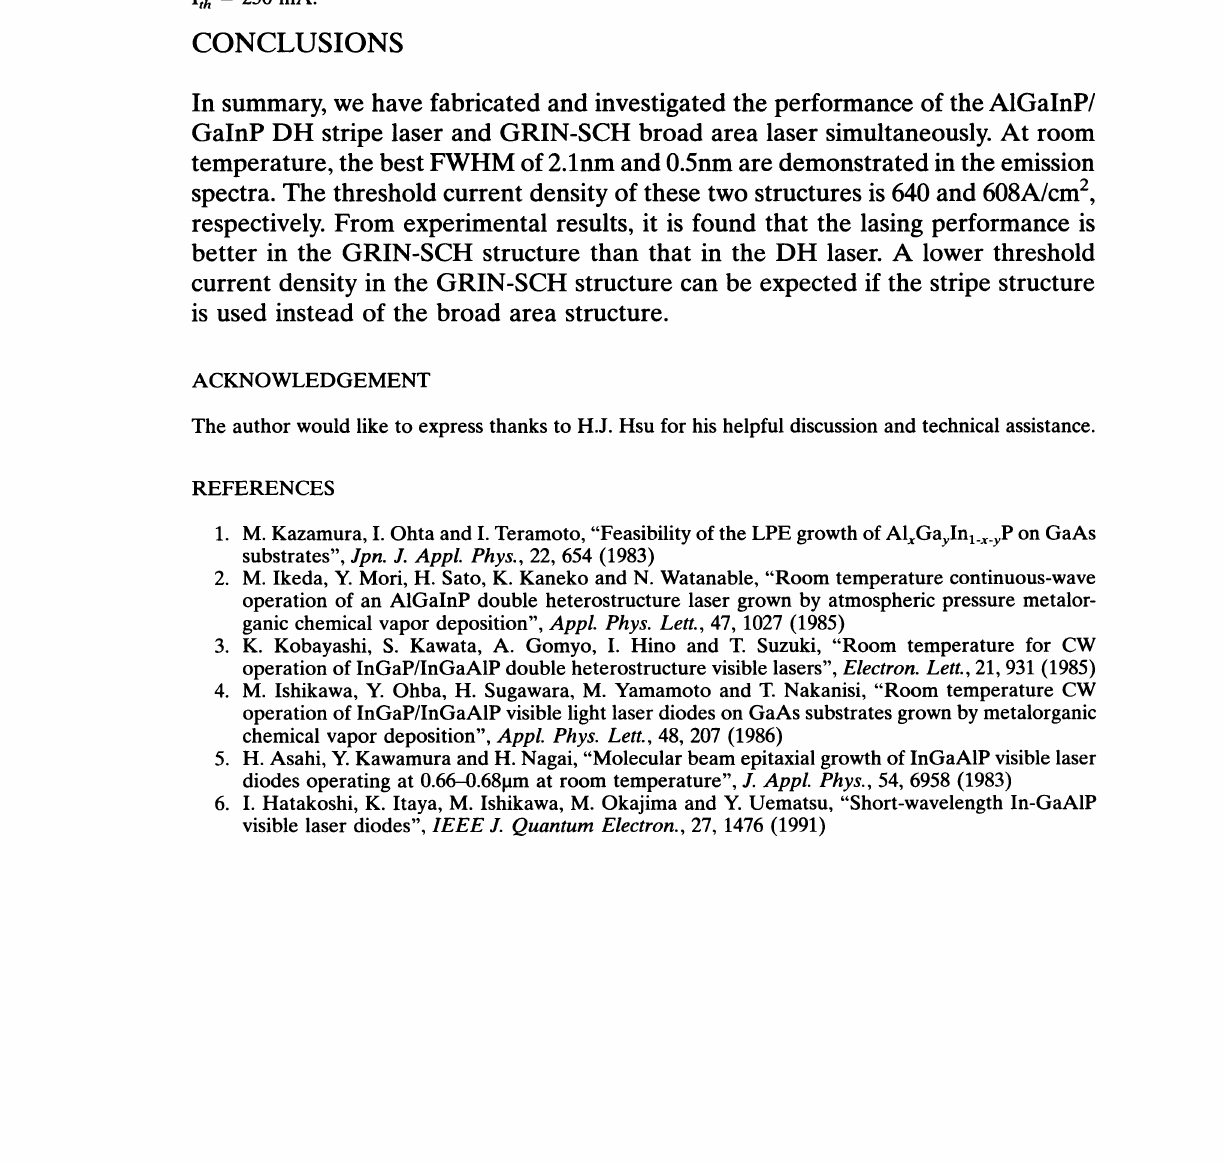
FIGURE 10 Measured GRIN-SCH laser spectrum under pulse operation when injection current > Ith 250